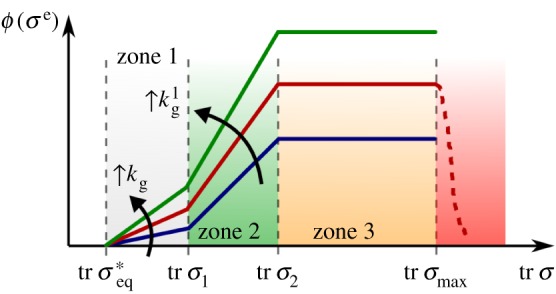
The variation of the parameters kg and k1g changes the slopes of the mechanical criterion ϕ(σe).